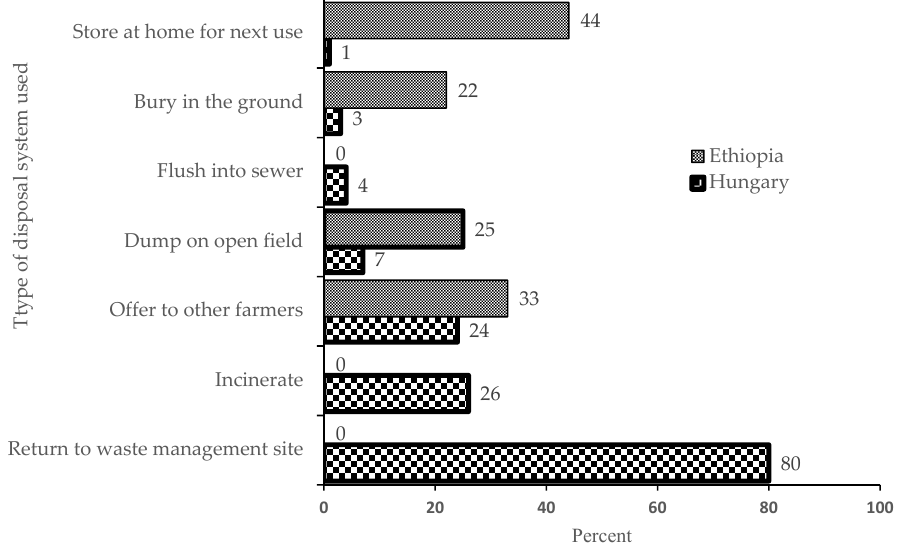
Figure 1. Pesticide residues disposal as reported by officers of the two study areas (Hungary n = 92; Ethiopia n = 234). Multiple choices were possible.